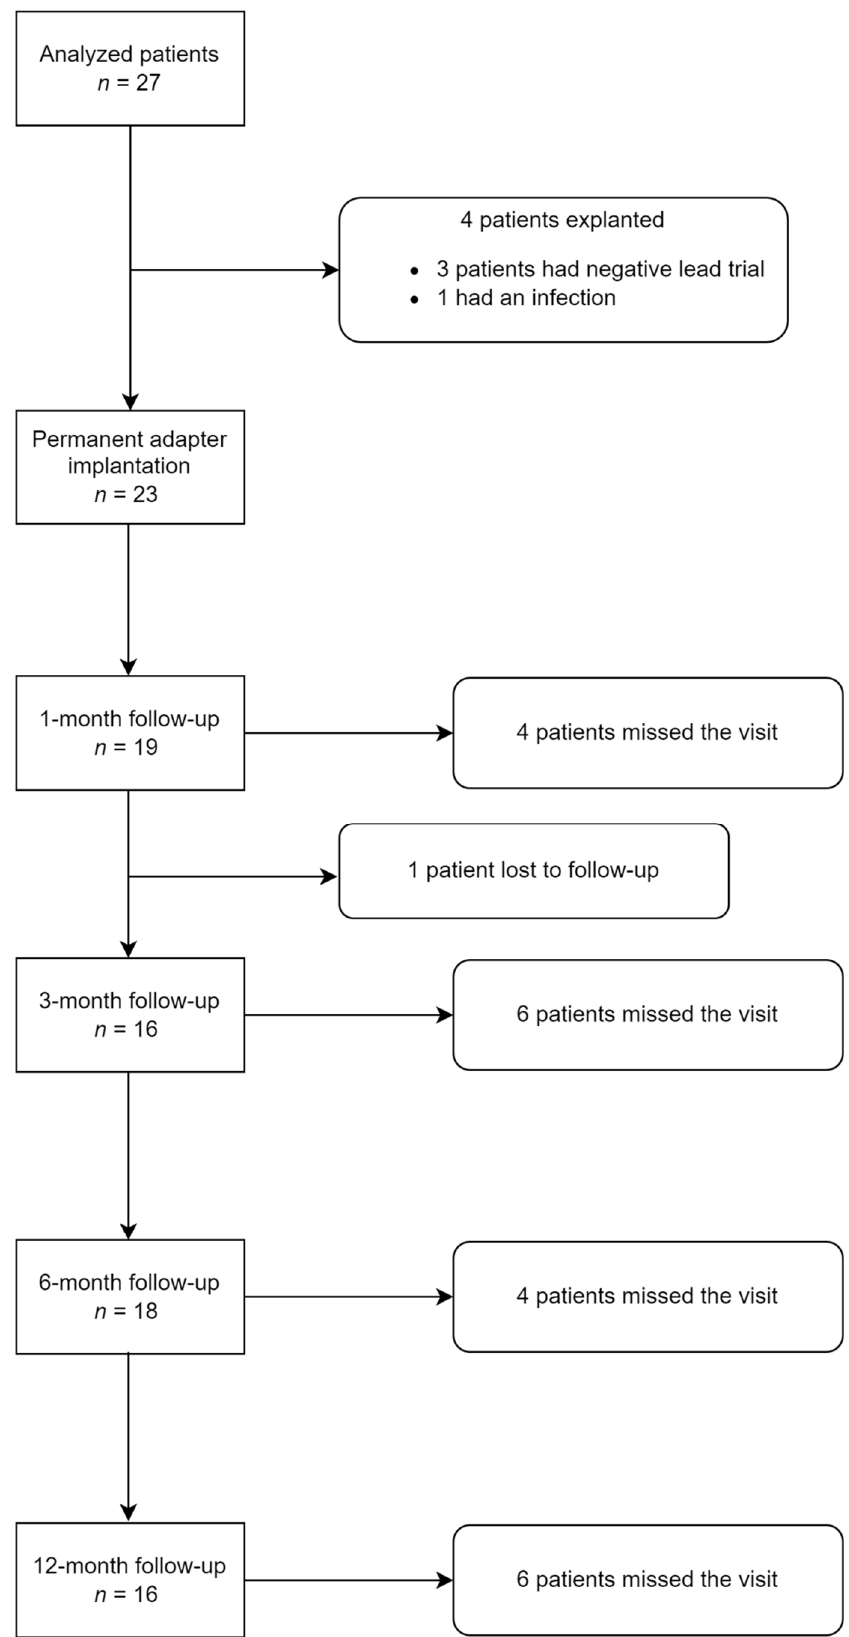
Figure 2. Patient flow chart.